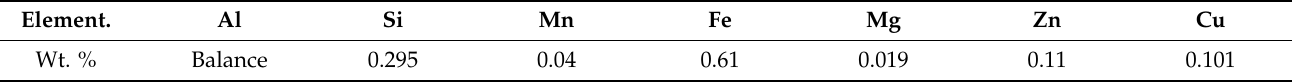
Table 1. Chemical components of AA1100.